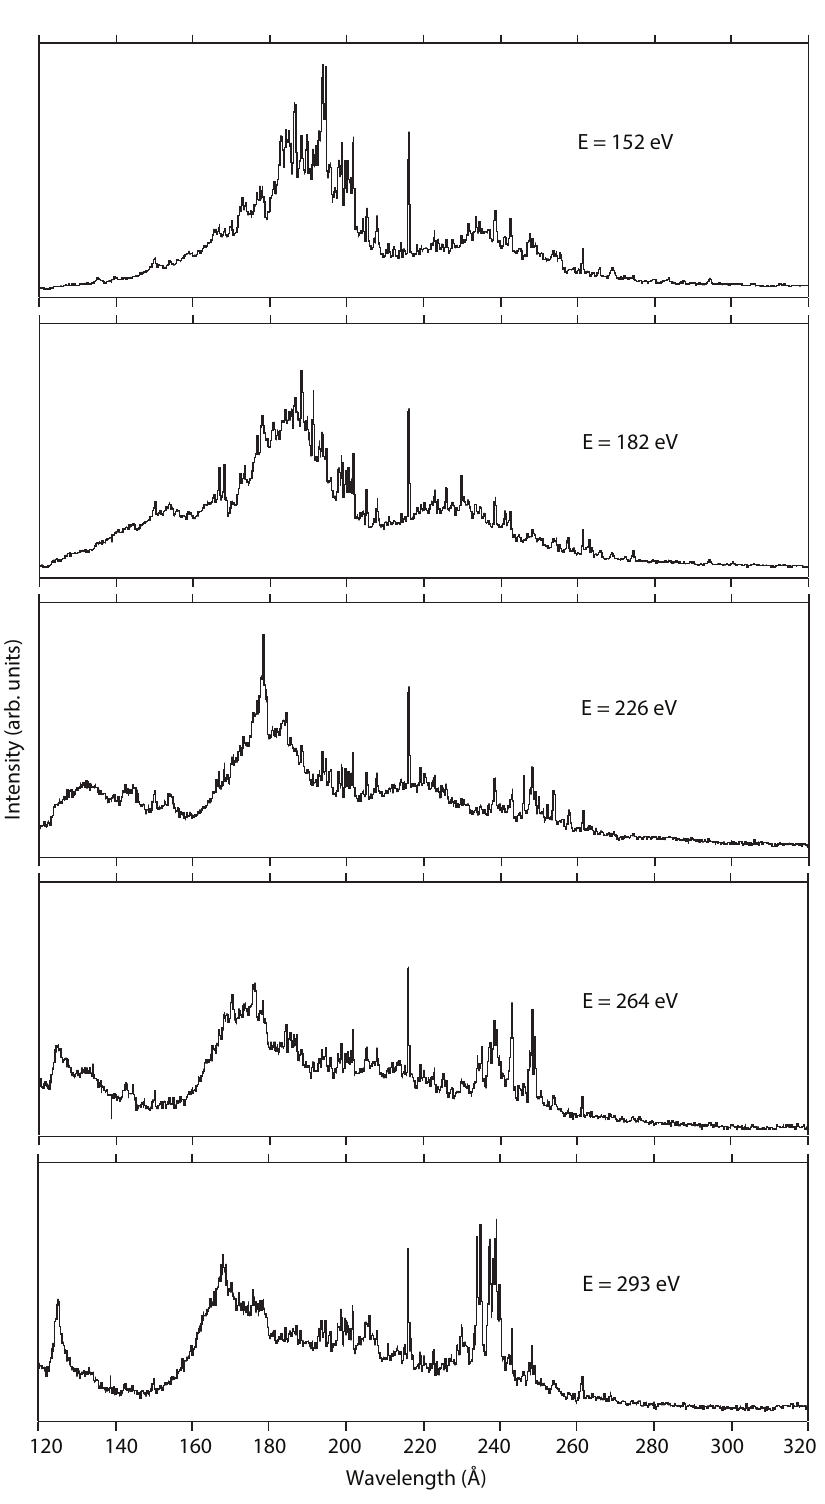
Figure 2. Tungsten spectra measured at EBIT-I at nominal electron-beam energies of E = 152–293